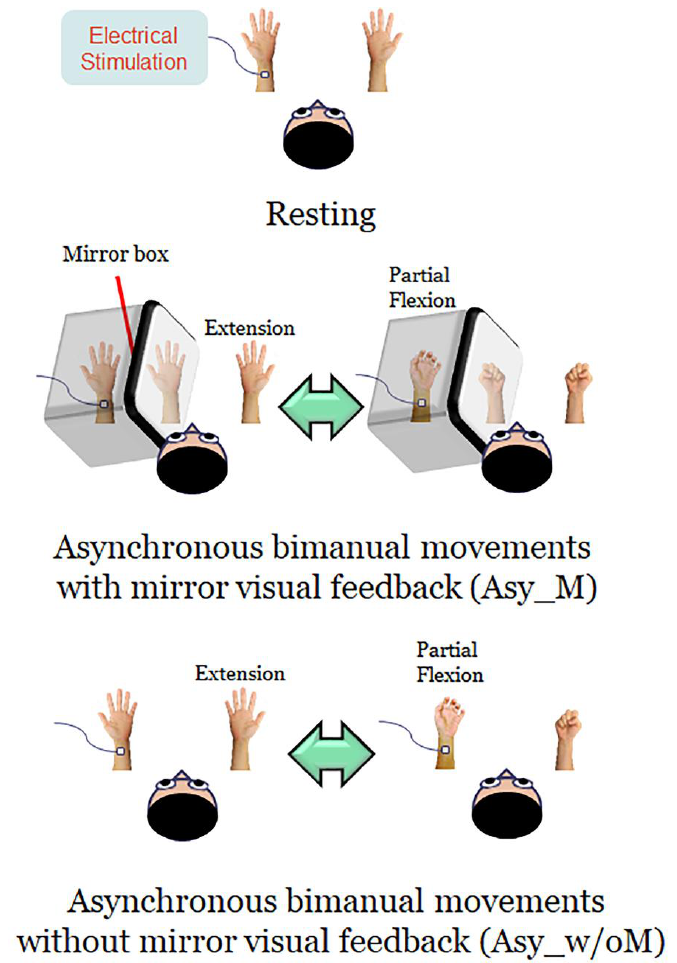
Figure 1. Illustration of the experimental design. In the resting condition, the participants were instructed to look at both stationary hands. In the asynchronous bimanual movement with mirror visual feedback (Asy_M), participants performed bimanual in-phase fingers flexion/extension with a mirror covering the left hand, in which the left hand performed partial range of movement while performing the full range of movement with their right hand. In the asynchronous bimanual movement without the mirror visual feedback (Asy_w/oM), the setup was similar to the Asy_M condition except that the mirror box was removed. During the whole experimental procedure, the left median nerve was stimulated at the wrist to probe the beta rebound oscillations of the primary motor cortex (M1).